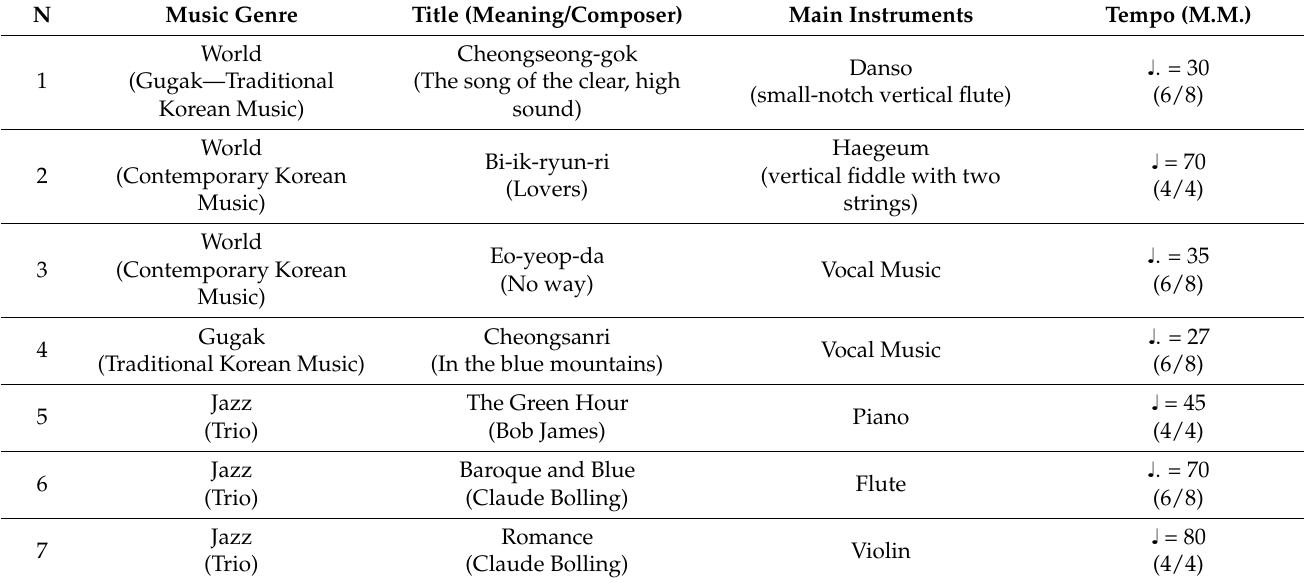
Table 1. Music selected for the Geneva Emotional Music Scales-9 (GEMS-9)